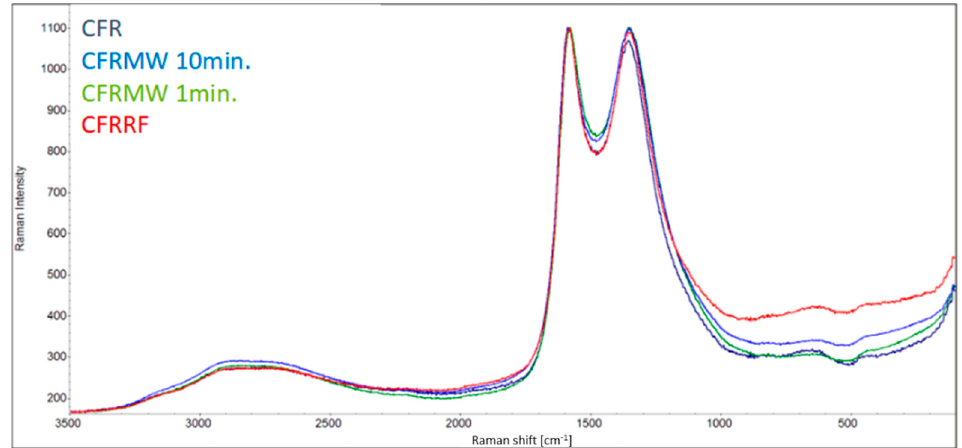
Figure 8. RS used